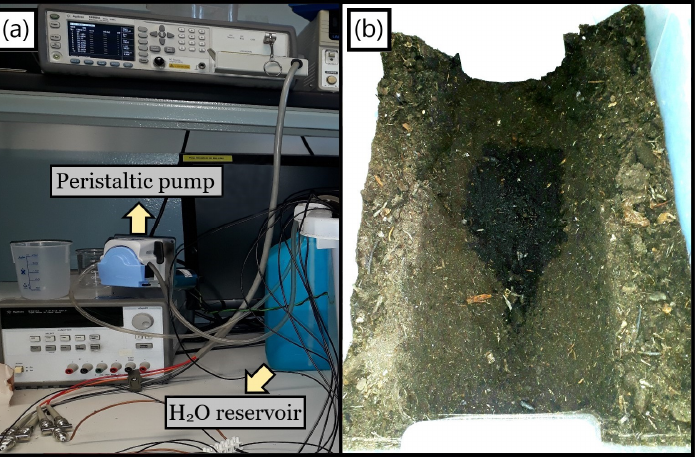
Figure 8. ( a ) Full setup for emulating a monitored leakage; ( b ) Real water loss photograph taken from above the rectangular plastic box initially filled with dry soil.